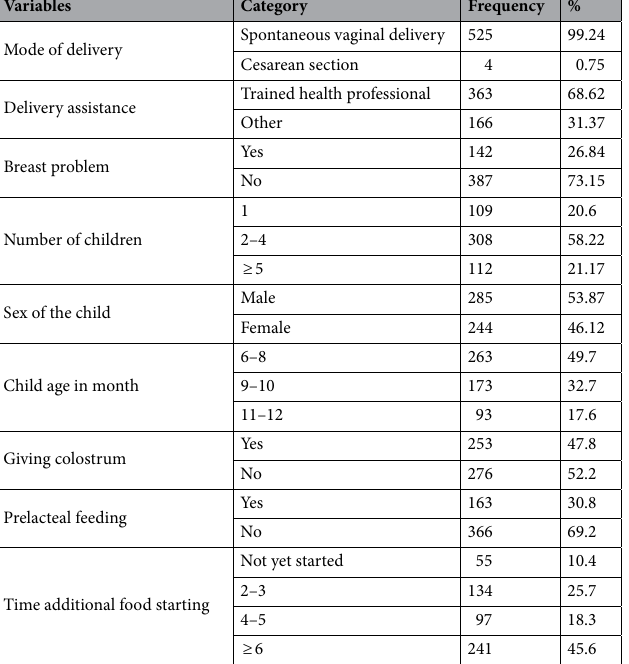
Table 2. Characteristics of children aged 6 months to 12 months and their mother in Chereti woreda Afder zone Somale region southwestern Ethiopia, 2019.